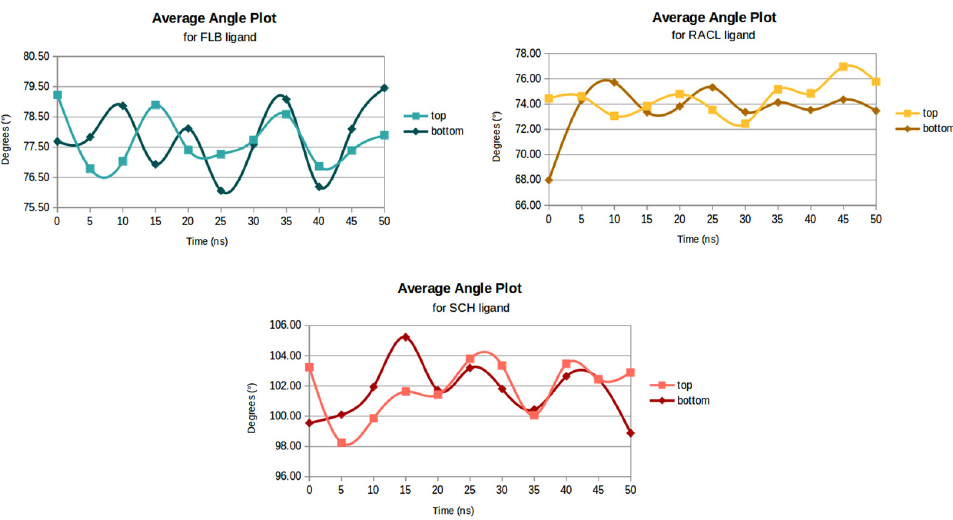
Figure 8. Average angle plots for each set of